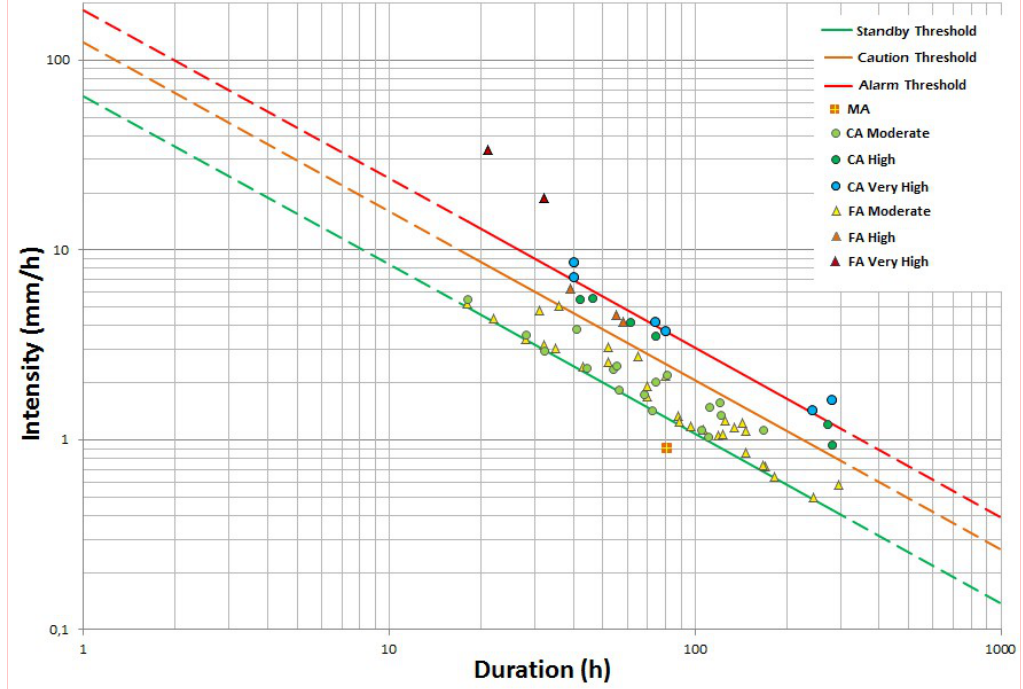
Figure 7. The thresholds for Teresópolis municipality. CA = correct alarm, FA = false alarm, MA = missed alarm.